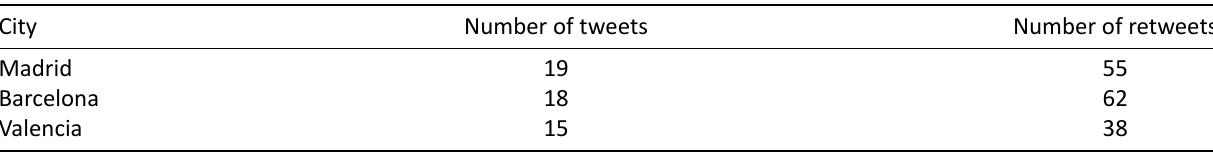
Table 2. Overall activity (in millions) by